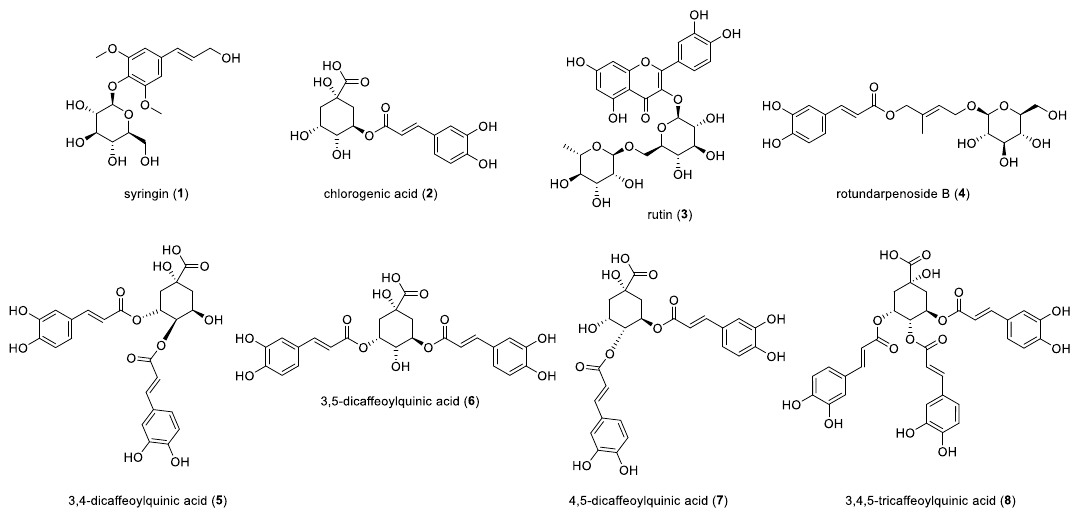
Figure 3. Structures of compounds 1 – 8 isolated from the extract of I. rotunda twigs.